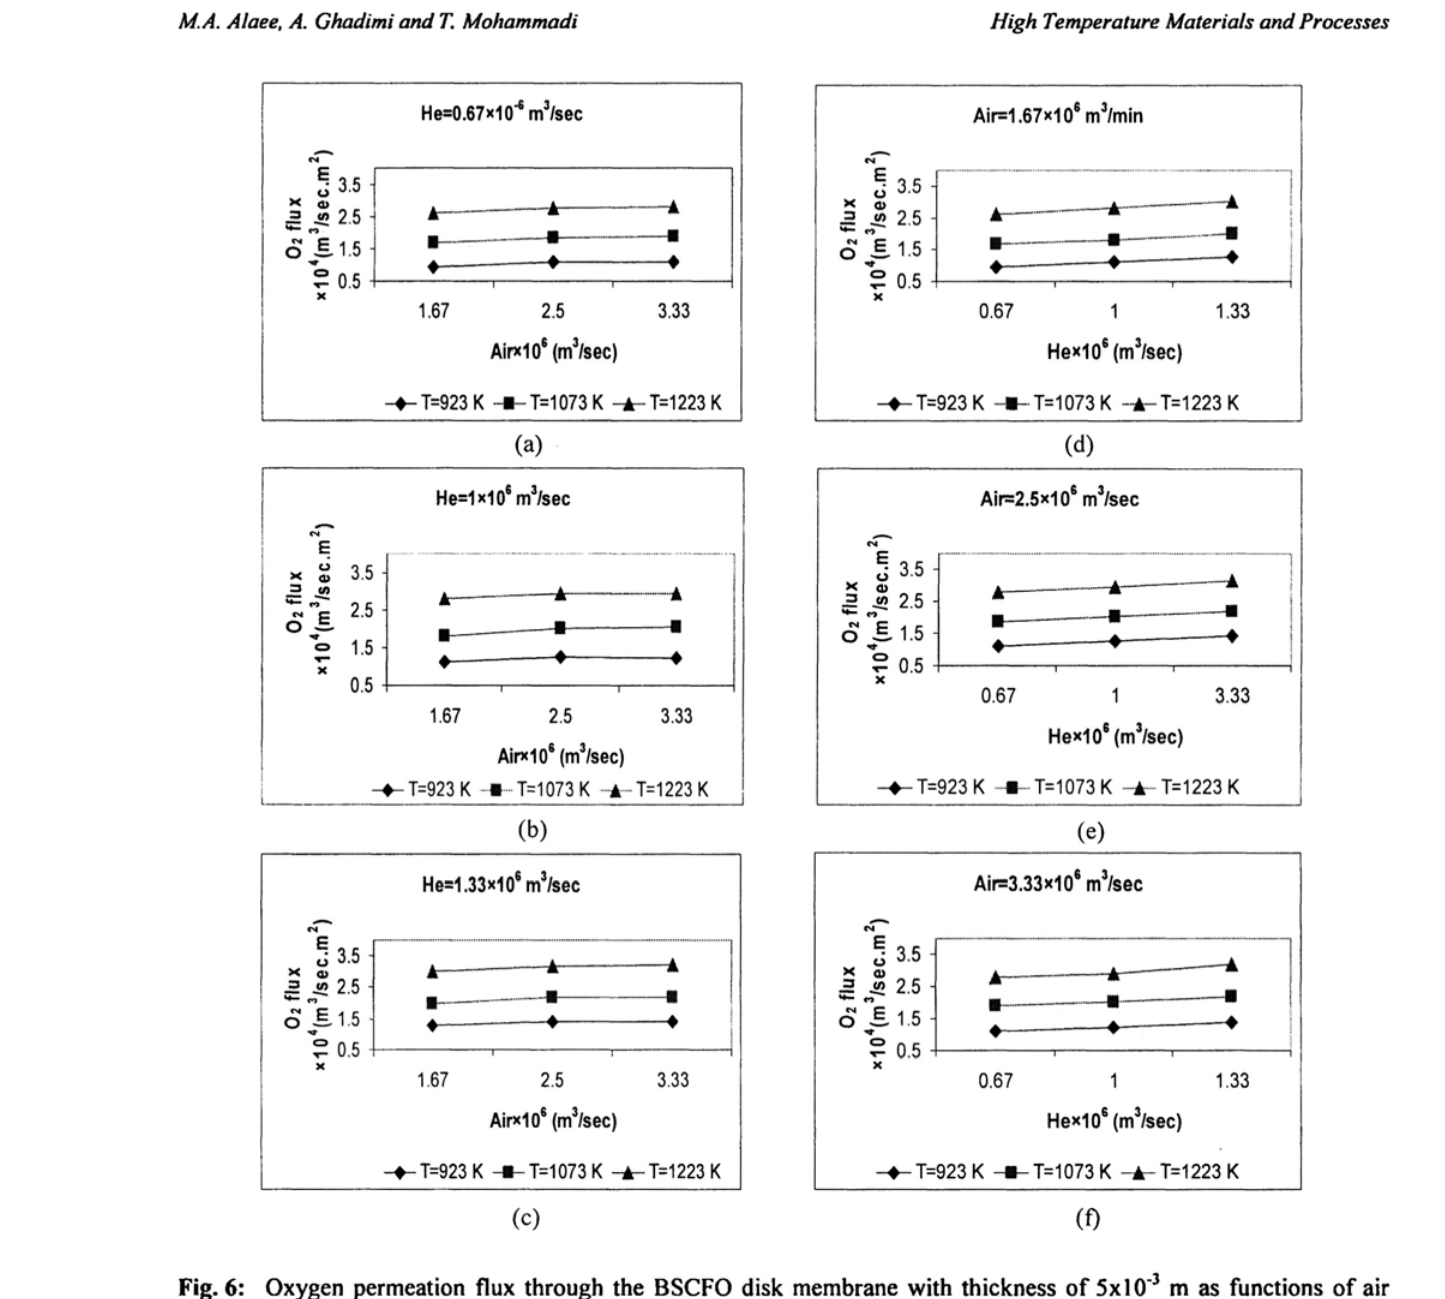
Fig. 6: Oxygen permeation flux through the BSCFO disk membrane with thickness of 5x10" 3 m as functions of air flow rate (a, b and c) in upstream side and helium flow rate in downstream side (d, e and f).